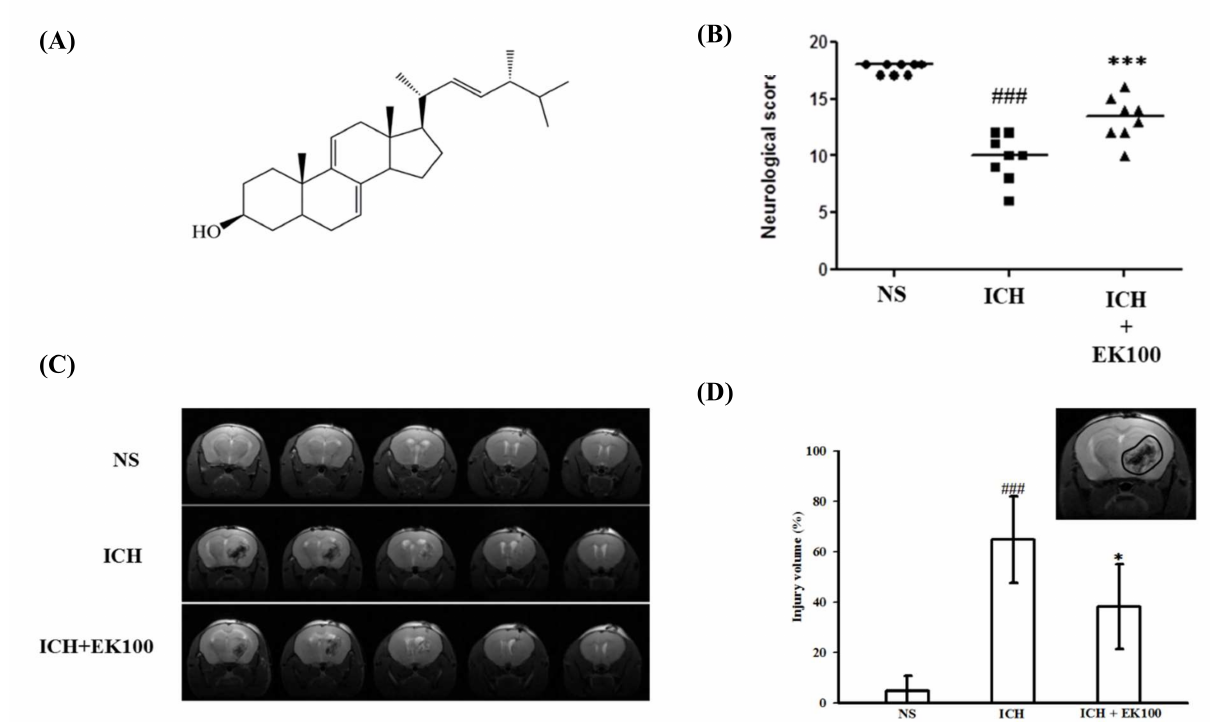
Figure 1. Effects of ergosta-7,9(11),22-trien-3 β -ol (EK100) on neurobehavioral deficits and neuroimaging abnormalities after intracerebral hemorrhage (ICH) in vivo. C57BL/6 mice were post-ICH orally administered EK100 (30 mg/kg) or vehicle at 30 min after the intrastriatal injection of 0.02 U collagenase to induce ICH. ( A ) The chemical structure of EK100 was shown. ( B ) The neurobehavioral deficit evaluation scores were shown as all six individual test scores after 24 h ( n = 8). The evaluations were described as details in the Methods section. ( C ) T2-weighted MRIs at 24 h after ICH treated with vehicle or EK100 (30 mg/kg) and their non-ICH control. ( D ) Bar graph demonstrating the lesion index expressed, as detailed in Materials and Methods. Values were expressed as the mean ± SD ( n = 4). ### p < 0.001 compared with ipsilateral NS (normal saline)-intrastriatal injected with vehicle treatment group; * p < 0.05, *** p < 0.001 compared with ipsilateral collagenase-intrastriatal injected with vehicle treatment group (ICH). The gated-locus used for evaluation of brain injury was